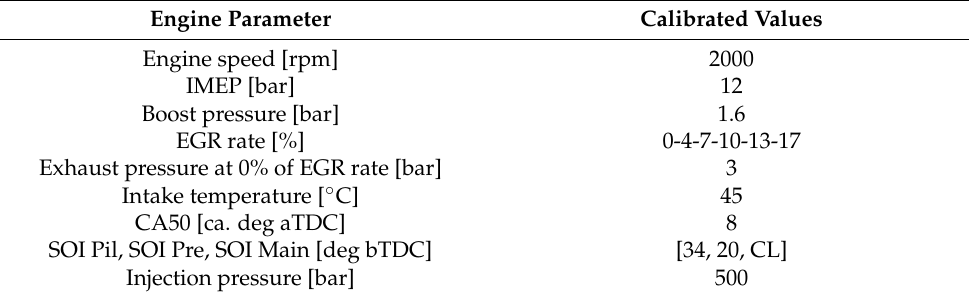
Table 6. Engine operating conditions during EGR rate